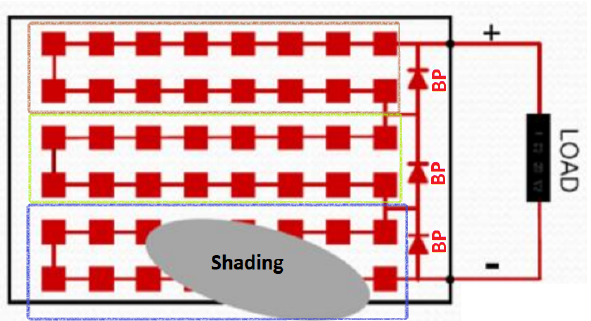
Figure 18. Schematic of a partially shaded photovoltaic panel.